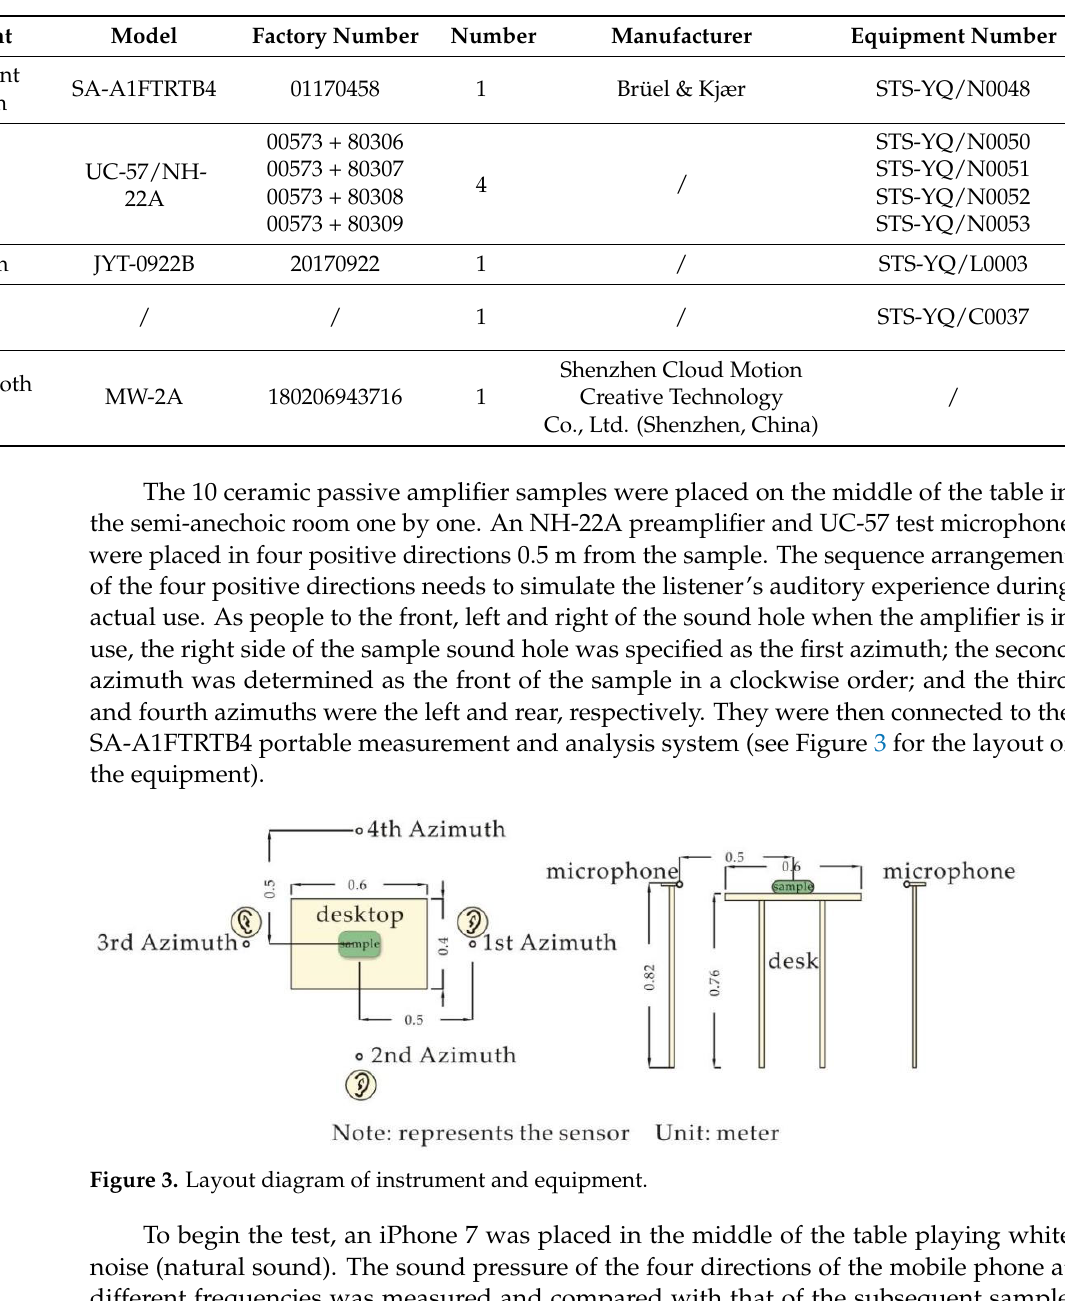
Table 1. Experimental equipment parameters.